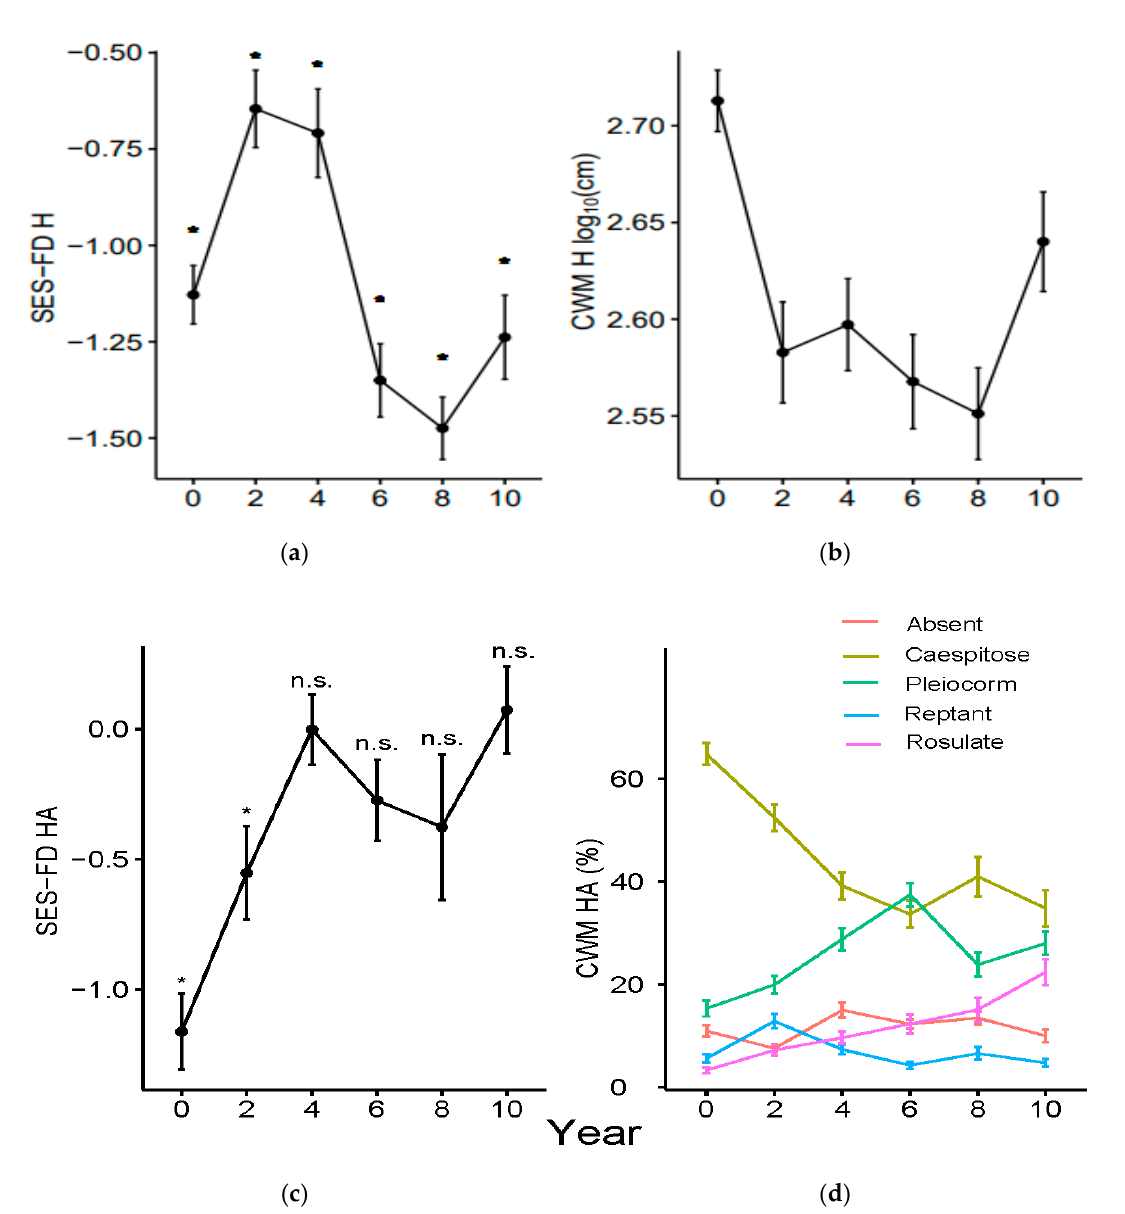
Figure 2. Trends of standardized effect size of functional diversity (SES-FD) and community weighted means (CWMs) (mean ± s.e.) for ( a , b ) plant height (H) and ( c , d ) horizontal architecture (HA) under twice-a-year mowing. Year 0 (before treatment) refers to 2010; years 2, 4, 6, 8, and 10 correspond to 2012, 2014, 2016, 2018, and 2020. The asterisk ( * ) and n.s. indicate whether the distribution of SES-FD is significantly or not significantly different from zero after a one-sample two-tailed t -test ( p < 0.05).